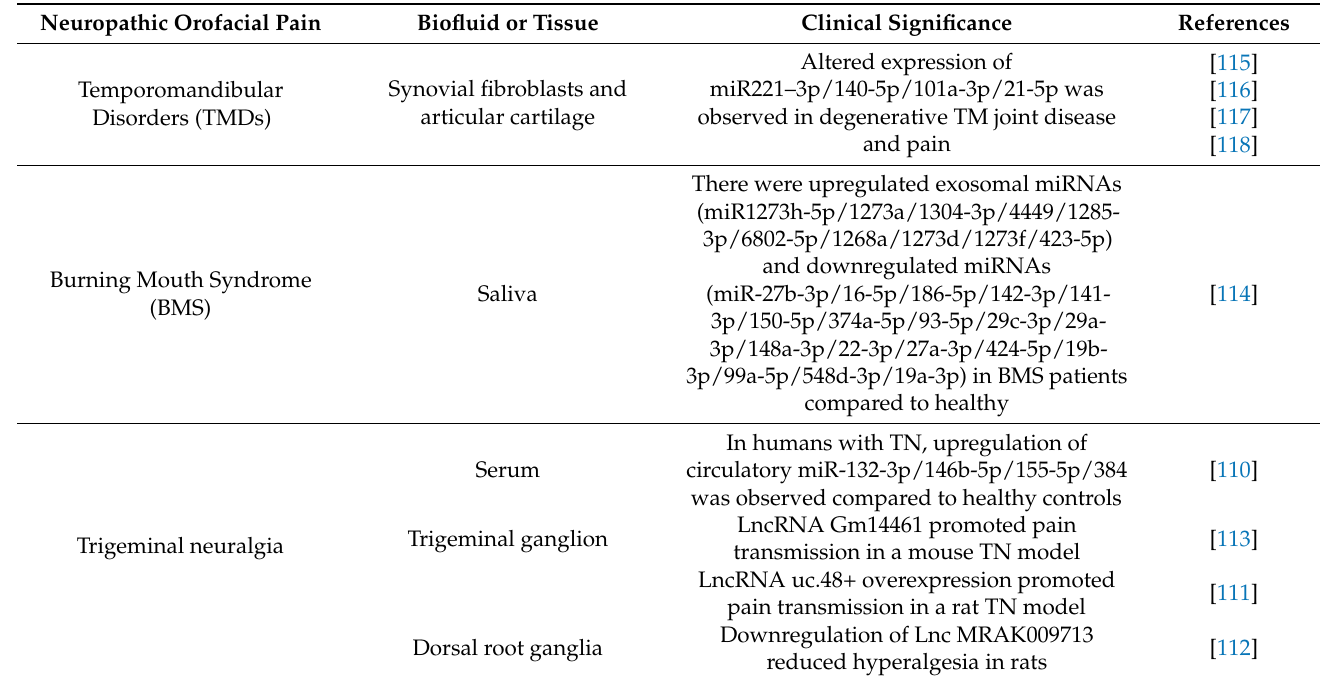
Table 6. ncRNAs as potential biomarkers of neuropathic orofacial